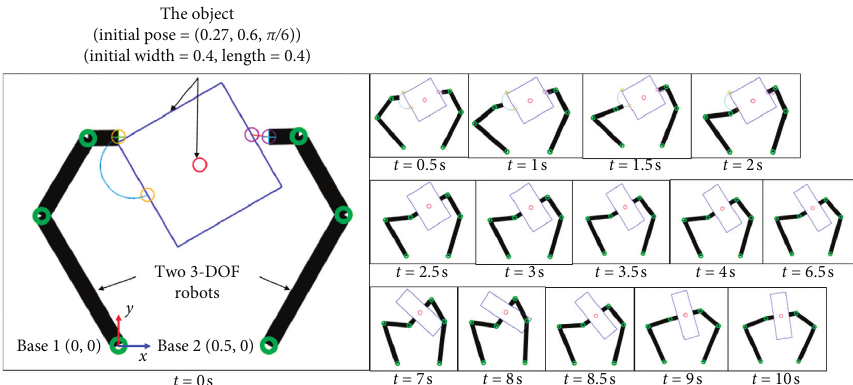
Figure 5: Some frames captured in the task described in Case